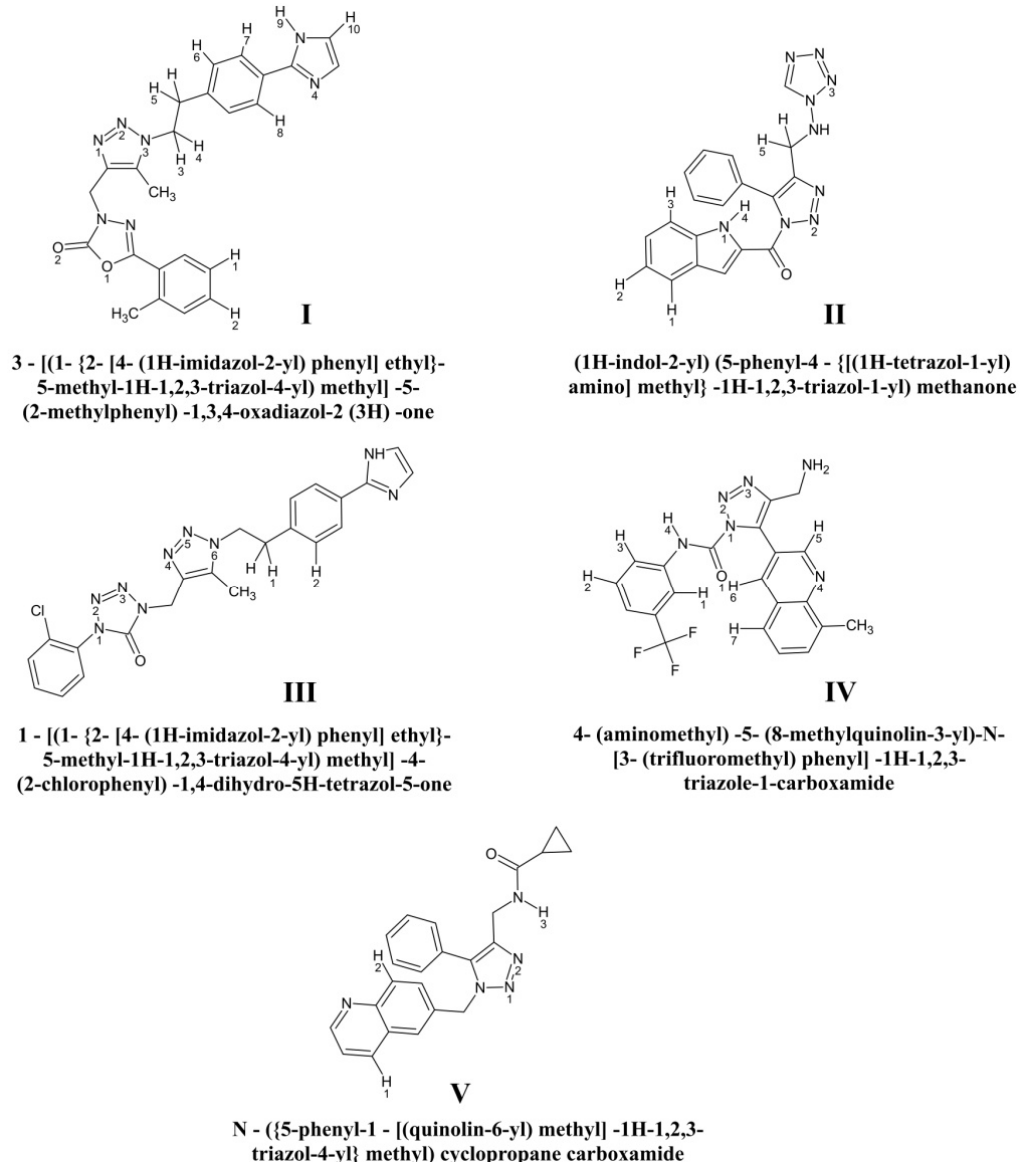
Figure 3. Chemical structures of the most promising CD4-mimetic candidates. Systematic names of these compounds are given. The hydrogen, oxygen and nitrogen atoms involved in the hydrogen bonds in the dynamic ligand / gp120 complexes are numbered (see the text).